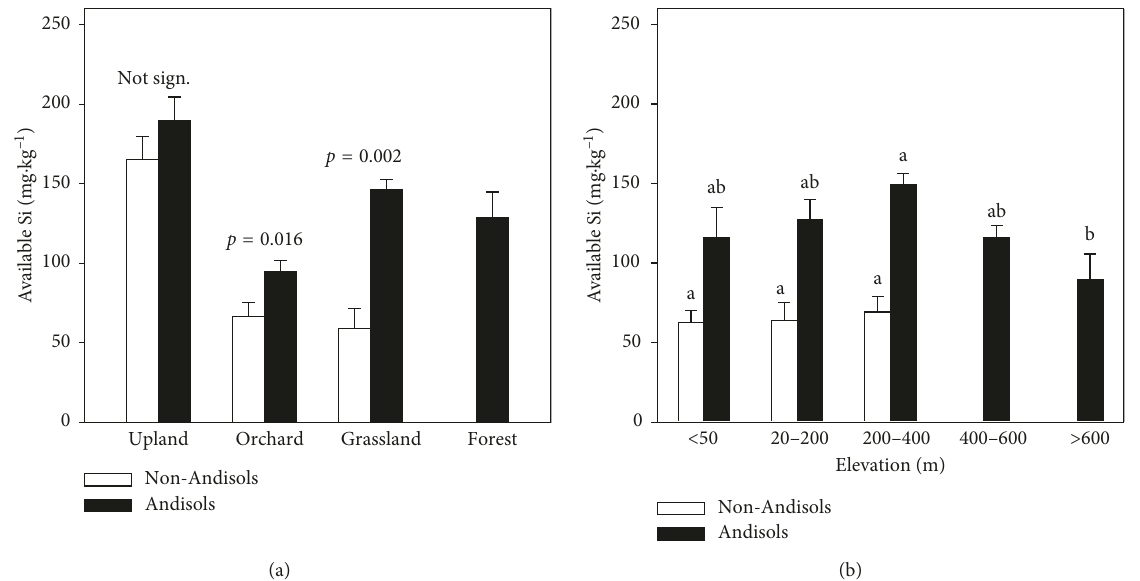
Figure 3: Comparison of available Si content in topsoils of non-Andisols and Andisols on Jeju Island according to land use types (a) and elevation (excluding upland soils) (b). Error bars indicate the standard error. Shown are the p values of Mann–Whitney U test analyses. Different letters above bars within the same soil type indicate significant differences among the elevations, as determined by Tukey’s HSD test computed with ranks after Kruskal–Wallis one-way ANOVA on ranks. For all analyses, a p value of 0.05 was considered significant. Table 1: Spearman rank correlation coefficients between the available Si content and the selected chemical properties of analyzed soils. Land use Soil Total ( n � 290)